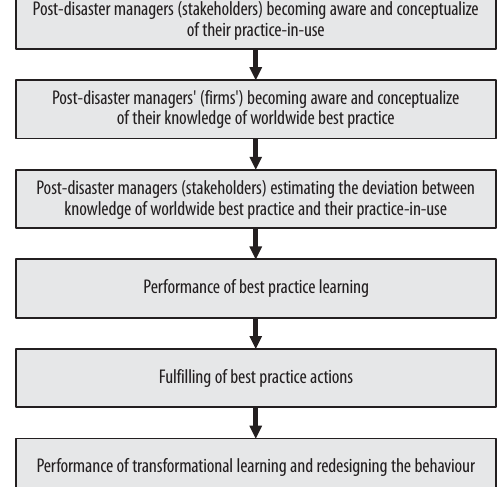
Figure 2. Performance of transformational learning and redesigning the manager’ mental and practical